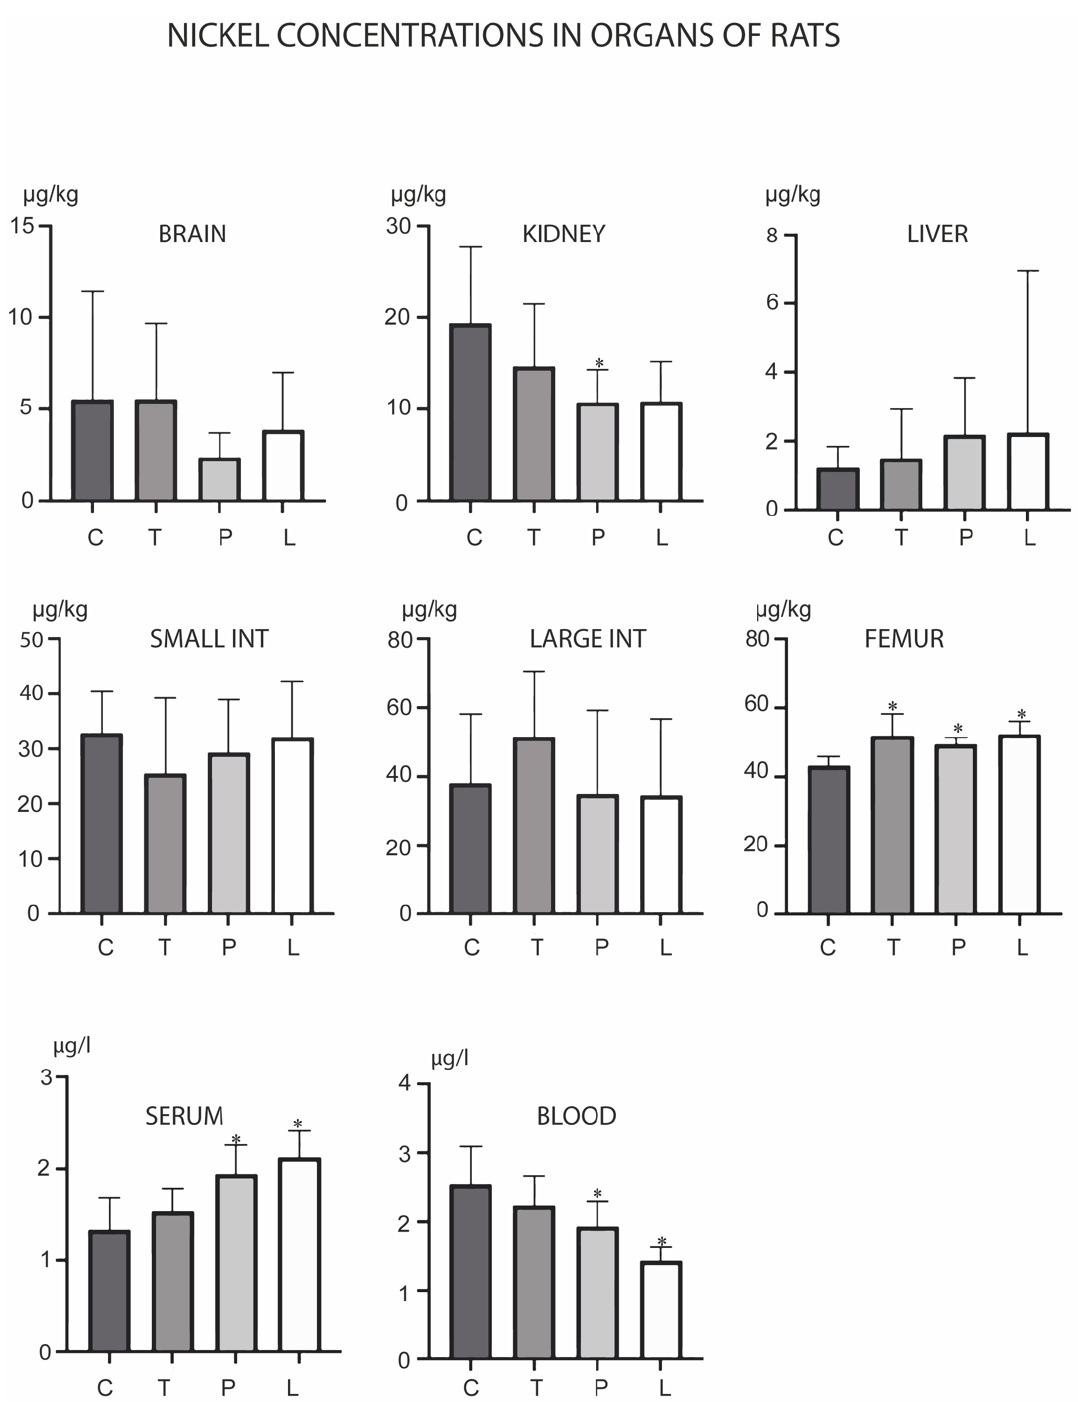
Figure 5. Concentrations of nickel in the brain, kidney, liver, small intestine, large intestine, serum, blood and femur after the three-month oral administration of silicates. C denotes the control group; T denotes the experimental group receiving TMAZ; P denotes the experimental group receiving PMA; and L denotes the experimental group receiving Ludox silica. Asterisk (*) denotes significant differences between the experimental groups, with control at p < 0.05.